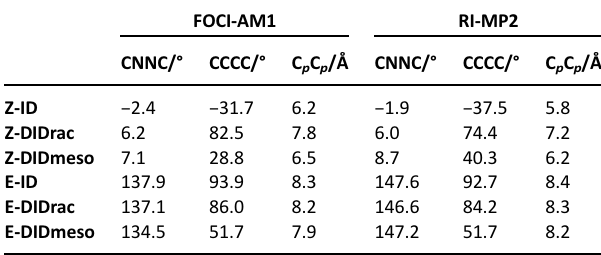
Table 2. Values for selected DOFs for the ID , DIDrac , and DIDmeso isomers.